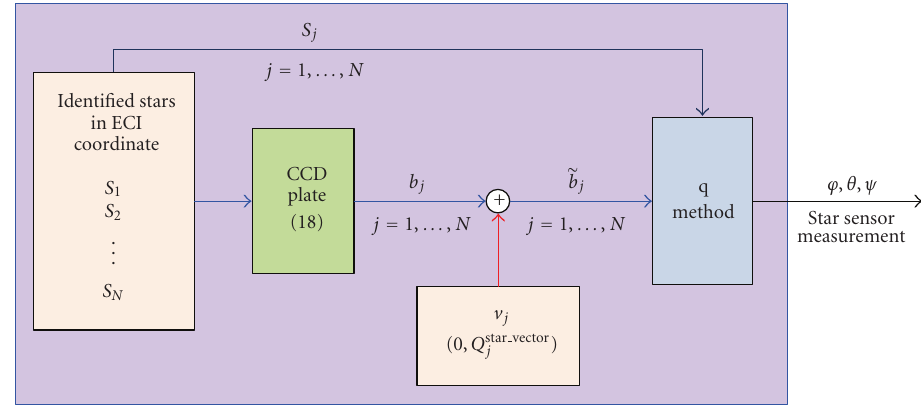
Figure 2: Star sensor